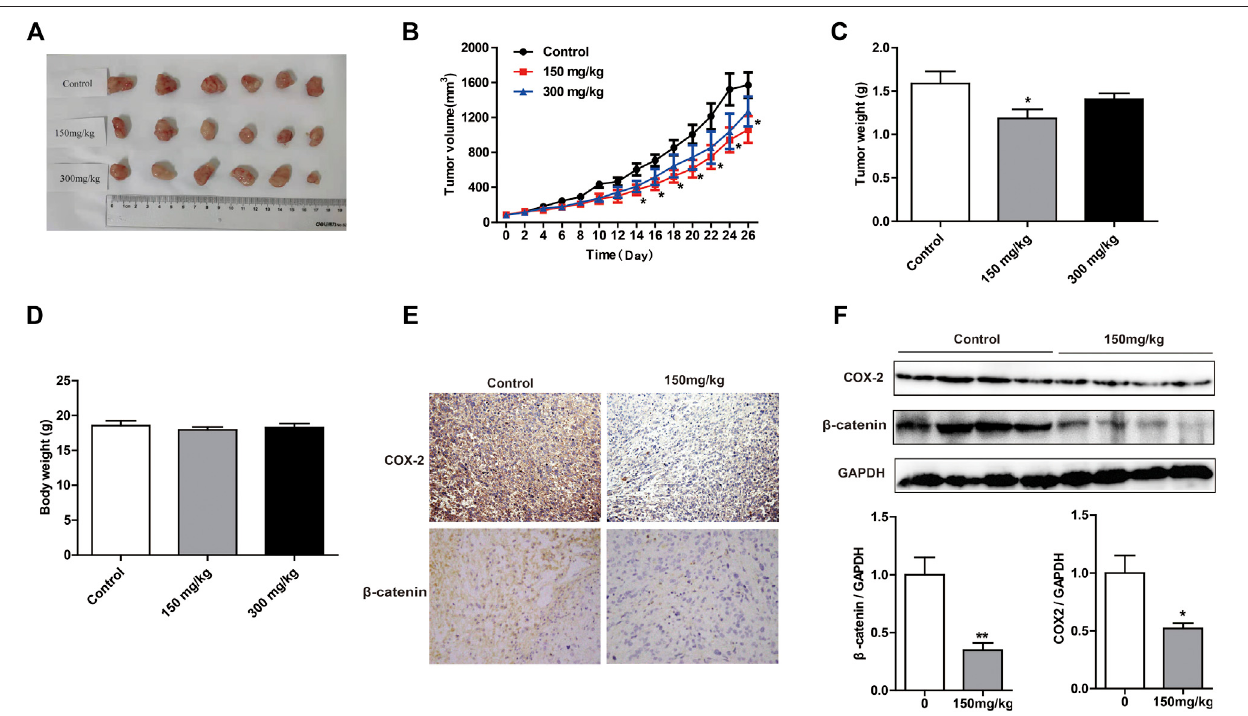
FIGURE5| TreatmentwithMOAinhibitedgrowthofsubcutaneousxenografttumors invivo . (A) Photographsoftumorsderivedfromnudemiceinthecontrol,150 and 300 mg/kg MOA groups ( n (cid:2) 6 per group). Changes in tumor volumes (B) , tumor weights (C) , and body weights (D) from the three groups of nude mice. (E) Representative photographs of IHC stainingof COX-2 and β -catenin intumorsfrom nude mice. (F) Western blotting analysis wasused todetermine the protein levels of COX-2and β -catenin, withGAPDHasaloadingcontrol.Resultsareexpressed asthemean ± SEMofthreeindependentexperiments. * p < 0.05and** p < 0.01vs.